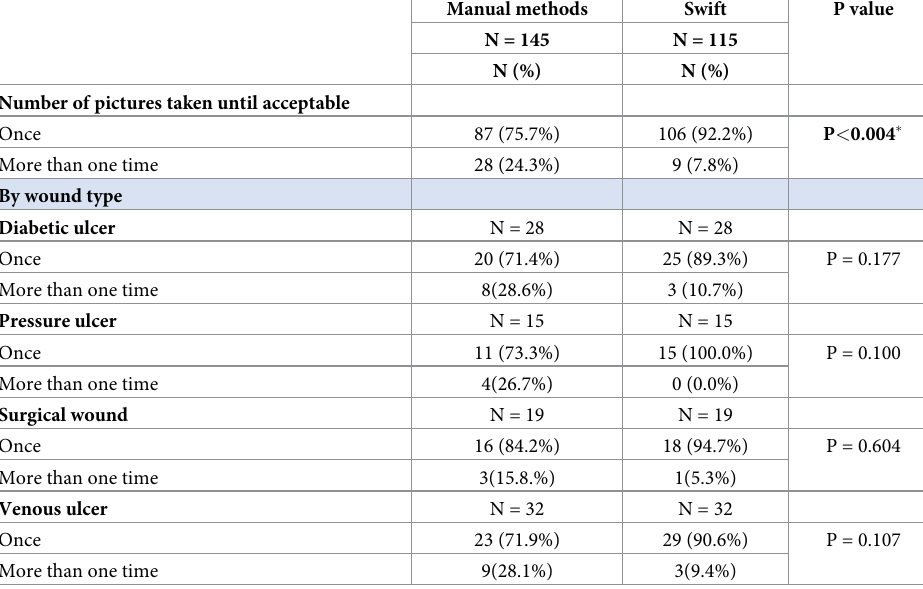
Table 1. Number of times pictures was taken until deemed acceptable by clinicians.